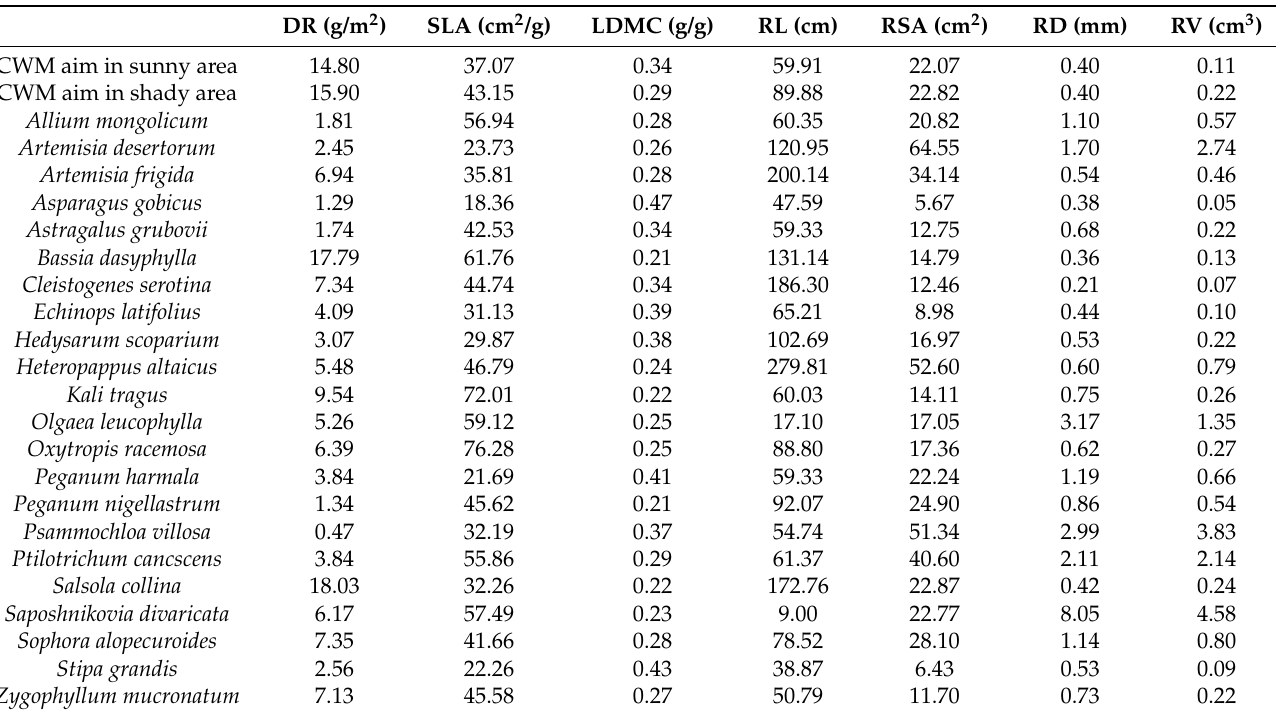
Table 2. Plant functional